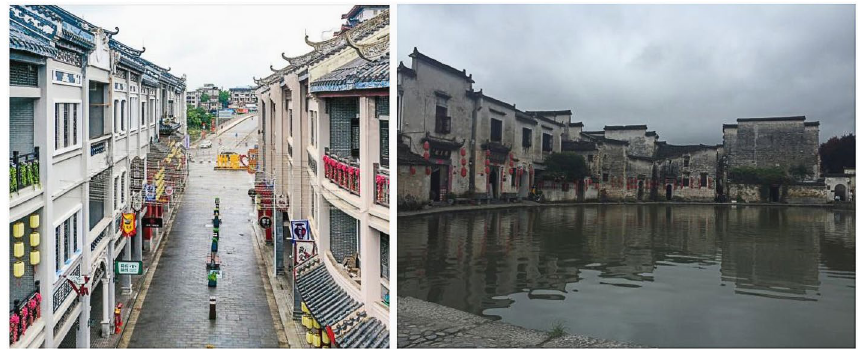
Fig. 5 Reconstructed Cantonese arcade houses in West Shuidong Street (left) versus Hui architecture (right). (Source: The